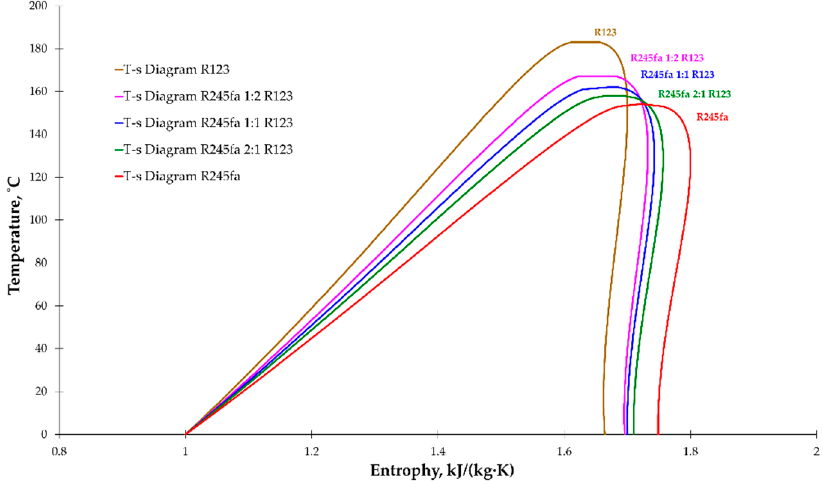
Figure 5. T–S diagram for R245fa, R123, and mixed working fluids.